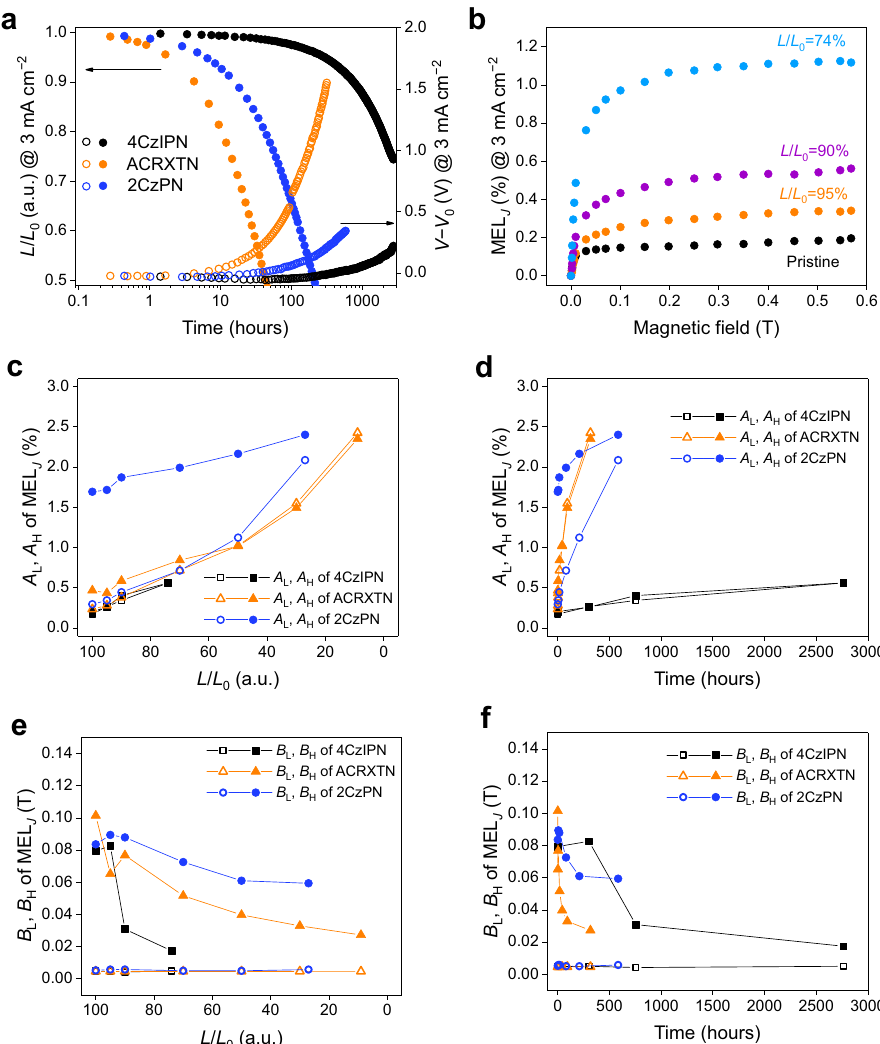
Fig. 3 Tracking TADF-OLED degradation via magnetic fi eld effects. a Luminance decays ( L / L 0 ) and operating voltage ( V − V 0 ) characteristics of 4CzIPN-, ACRXTN-, and 2CzPN-based OLEDs with a constant current density of 3.0mAcm − 2 . L and V are the luminance and driving voltage, respectively. L 0 and V 0 are the initial luminance and driving voltage of degradation test, respectively. b Magneto-electroluminescence (MEL J ) pro fi les of pristine and degraded 4CzIPN-based OLEDs. c Relationship between luminance decay and the amplitudes of low- fi eld and high- fi eld effects in MEL J . d Relationship between luminance decay and the characteristic fi elds of low- fi eld and high- fi eld effects in MEL J . e Relationship between operating time and the amplitudes of low- fi eld and high- fi eld effects in MEL J . f Relationship between operating time and the characteristic fi elds of low- fi eld and high- fi eld effects in MEL J